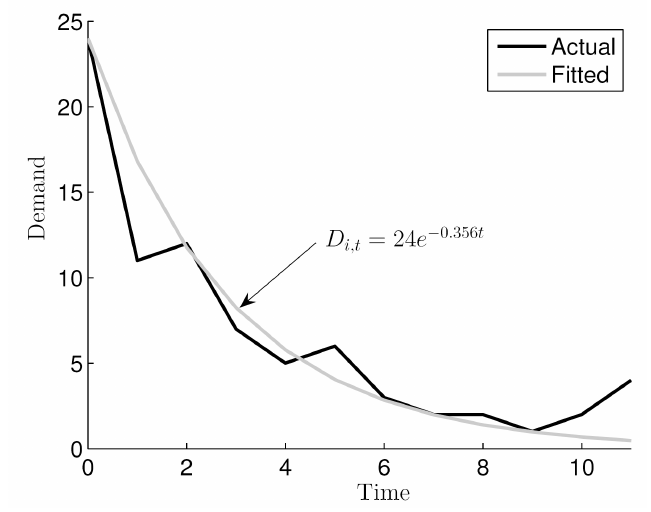
Figure 1: Exponentially decaying demand pattern fitted to an actual demand